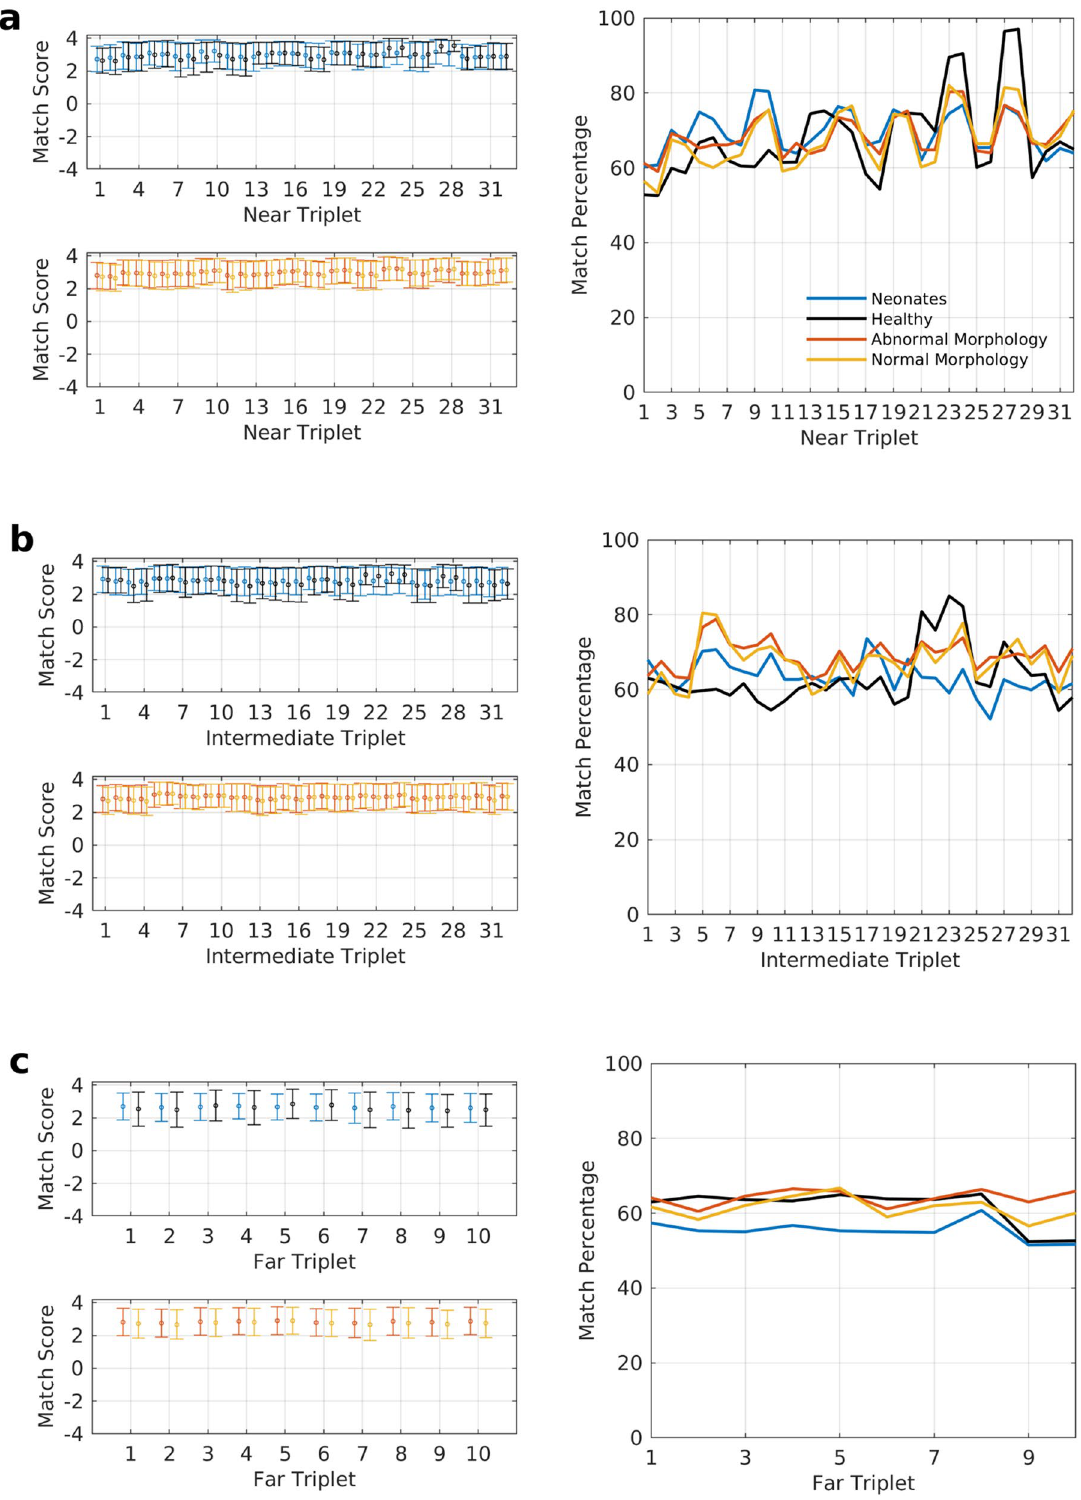
Figure 4. Match scores and match percentages for near, intermediate and far sets of triplets for data sets 2–4. The triplets have been assigned to their respective sets based on the mutual separation of the electrodes within a triplet. Each triplet in the three sets is represented by a number given in Supplementary Table S2. Consecutive odd and even numbered triplets are mirror images of each other in the two opposing cerebral hemispheres. The error bars represent 1 standard deviation. ( a ) Match scores and percentages for triplets in the near set. The triplets are arranged such that traversing towards the right on the x-axis corresponds to moving from the frontal portion of the scalp to the back. ( b ) Match scores and percentages for triplets in the intermediate set. With 2410 EEG records of 2356 subjects in the three data sets, 32 triplets for each record, and six permutations per triplet, ( a , b ) represent statistics of 462,720 connectivity patterns each. c Match scores and percentages of 144,600 connectivity patterns in the far set with 10